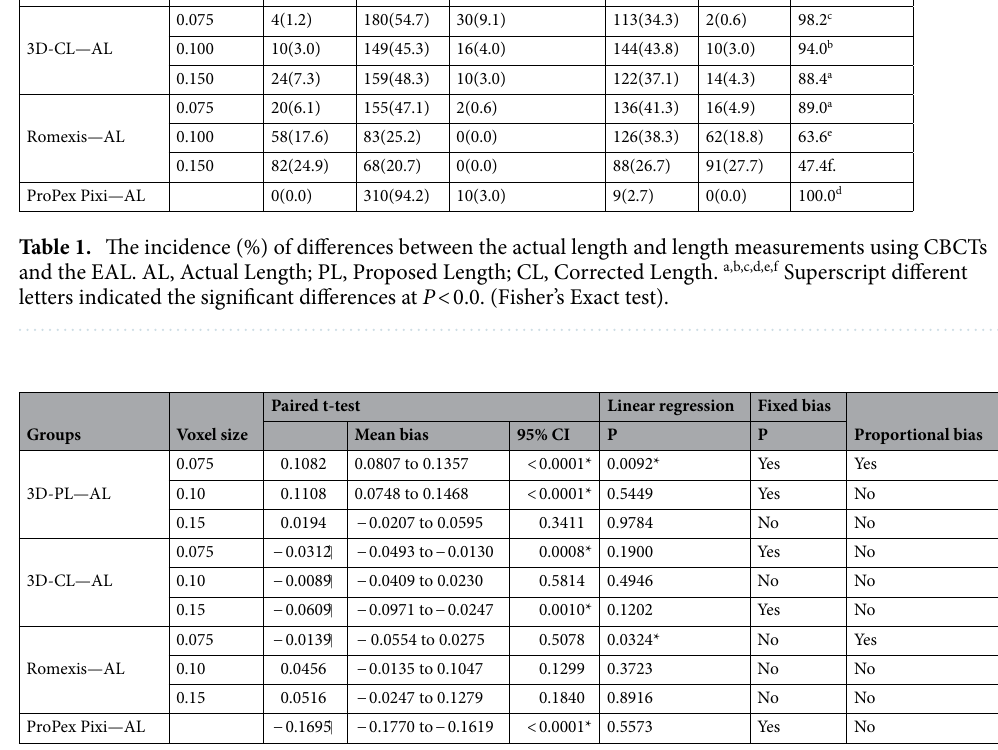
Table 2. Mean biases, standard deviations, confidence intervals, P values in two statistical tests, fixed or proportional biases for different methods’ measurements. * Differences at significant level of 0.05.